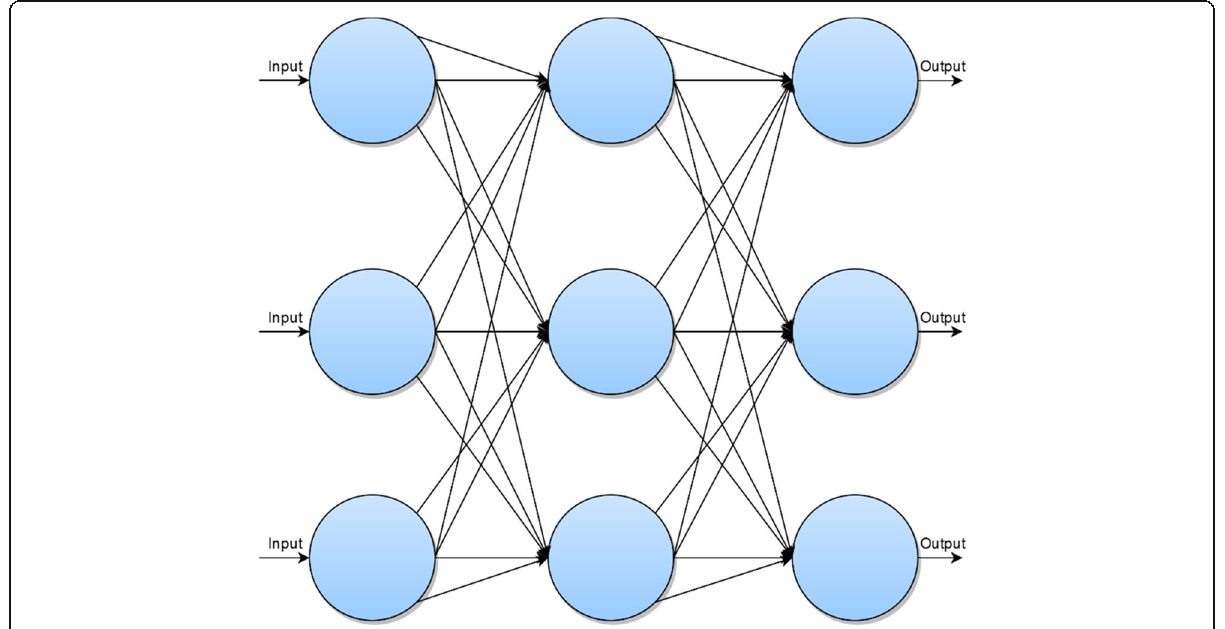
Fig. 2 Diagrammatic representation of a convolutional neural network